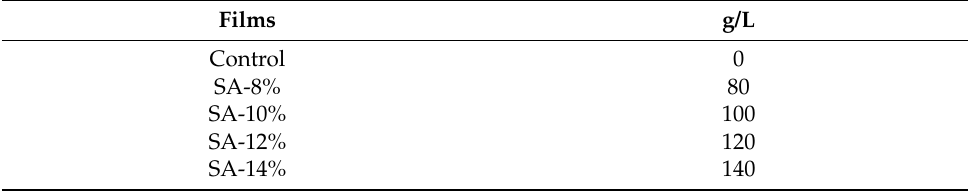
Table 1. Amount of anthocyanin being used throughout the preparation of each film. Films g/L